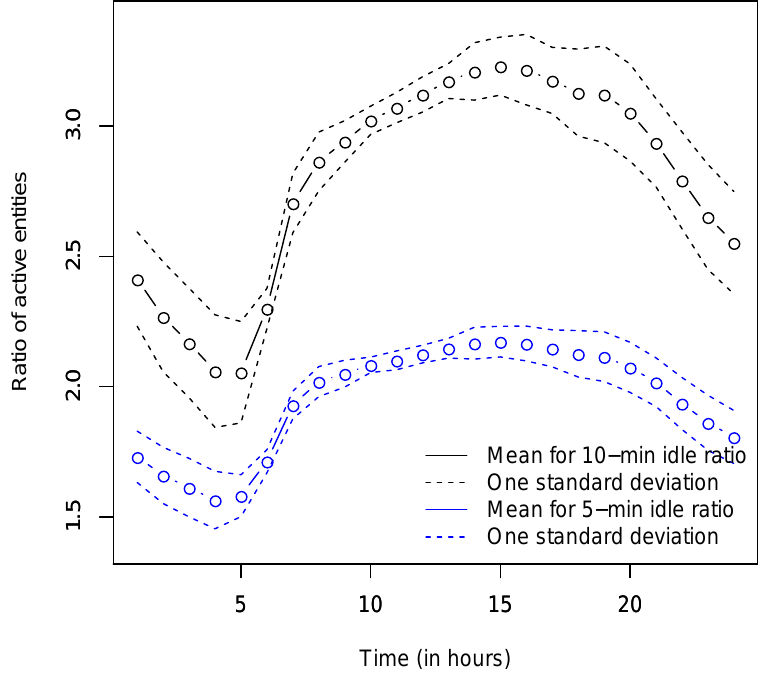
Figure 24. The ratio of active entities when destroying them after 10 and 5 min, over the baseline of destroying them right away, once UEs go back to idle